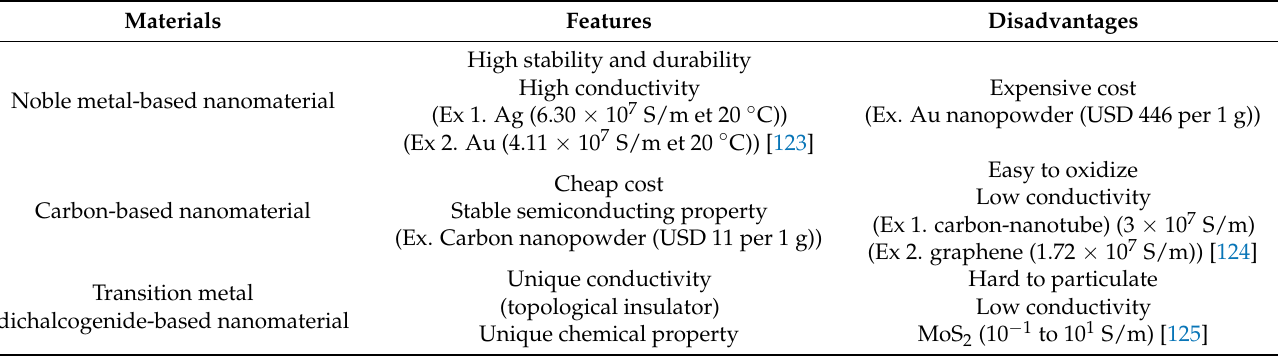
Table 2. Features and disadvantages of each nanomaterial for MC biosensor